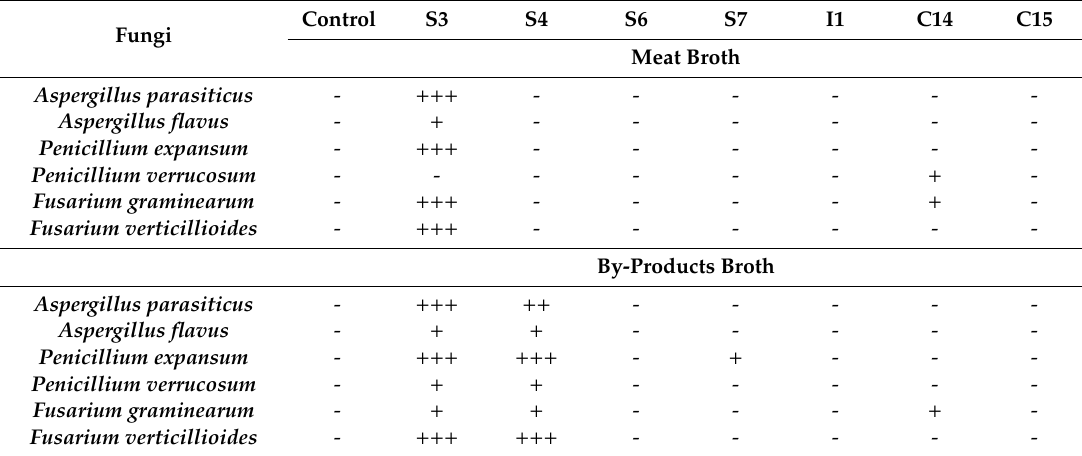
Table 2. Results of antifungal activity of fermented MB and WB in solid